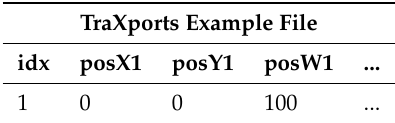
Table 2. Example of TraXports CSV